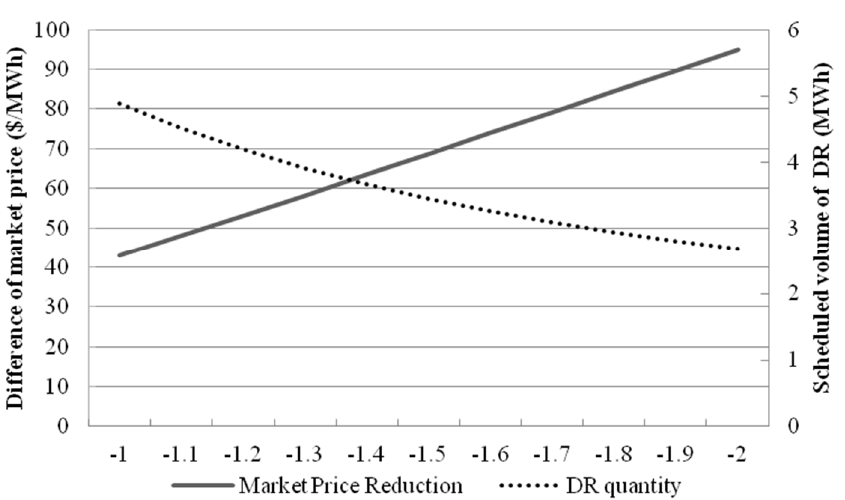
Figure 5. The scheduled I/C and the difference in price between our method and oligopoly conditions. The horizontal axis is the gradient of the demand function, the left vertical axis is the difference between market prices, and the right vertical axis shows the scheduled I/C.